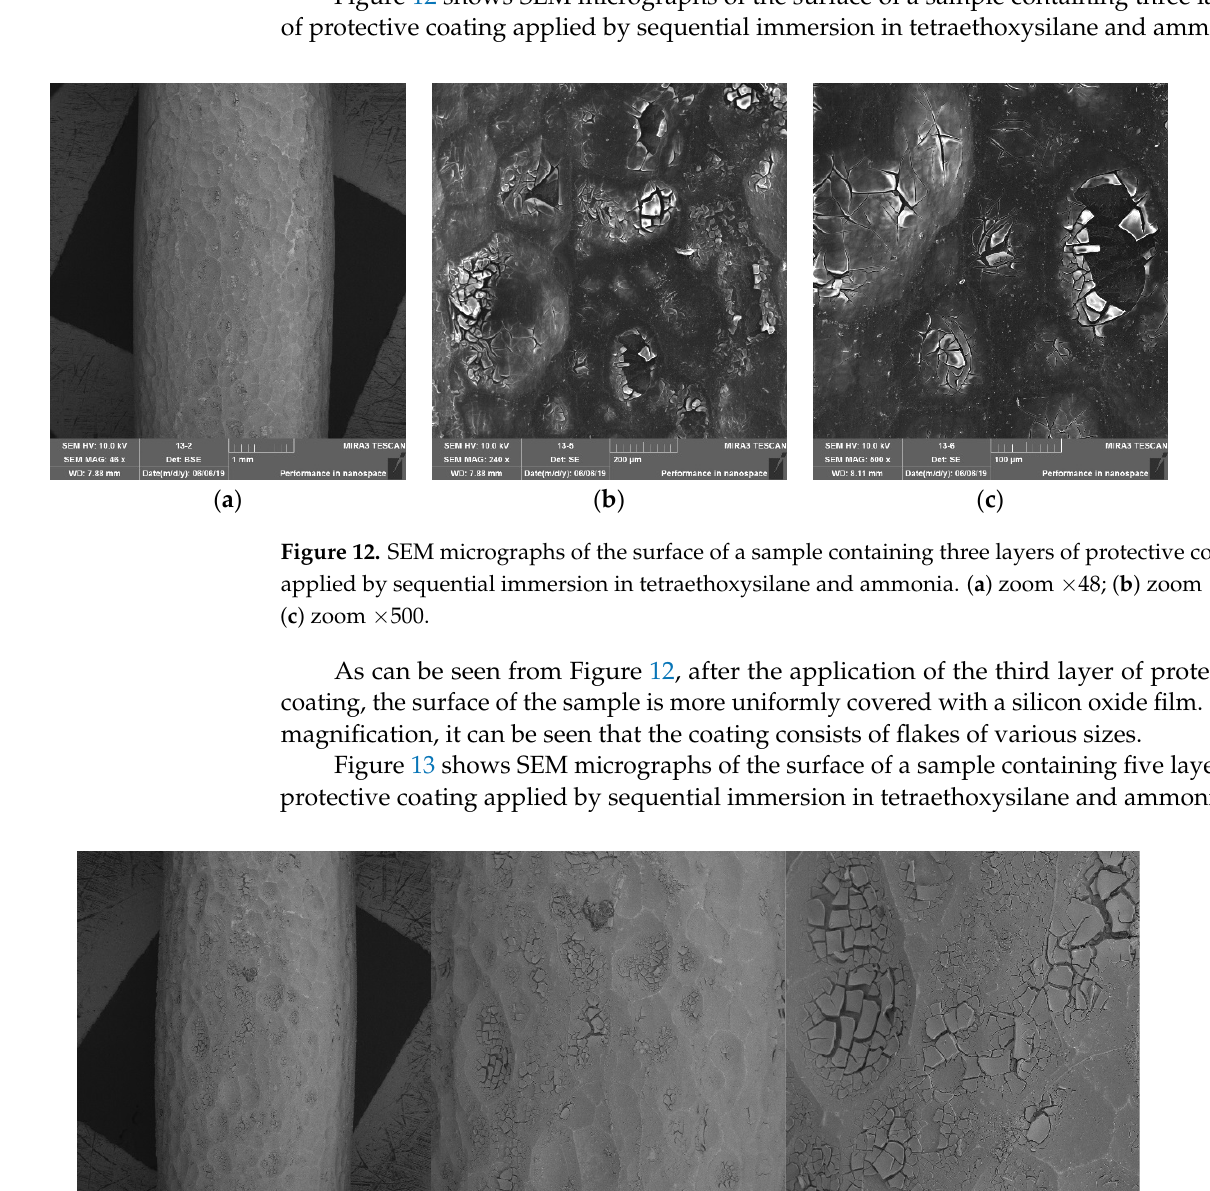
( c ) Figure 14. SEM micrographs of the surface of a sample containing one layer of protective coating applied by immersion in SiO 2 nanoparticles sol. ( a ) zoom ×42; ( b ) zoom ×32,000; ( c ) zoom ×64,000. ( a ) ( b ) ( c ) Figure 15. SEM micrographs of the surface of a sample containing three layers of protective coating applied by immersion in SiO 2 nanoparticles sol. ( a ) zoom ×44; ( b ) zoom ×100; ( c ) zoom ×64,000.